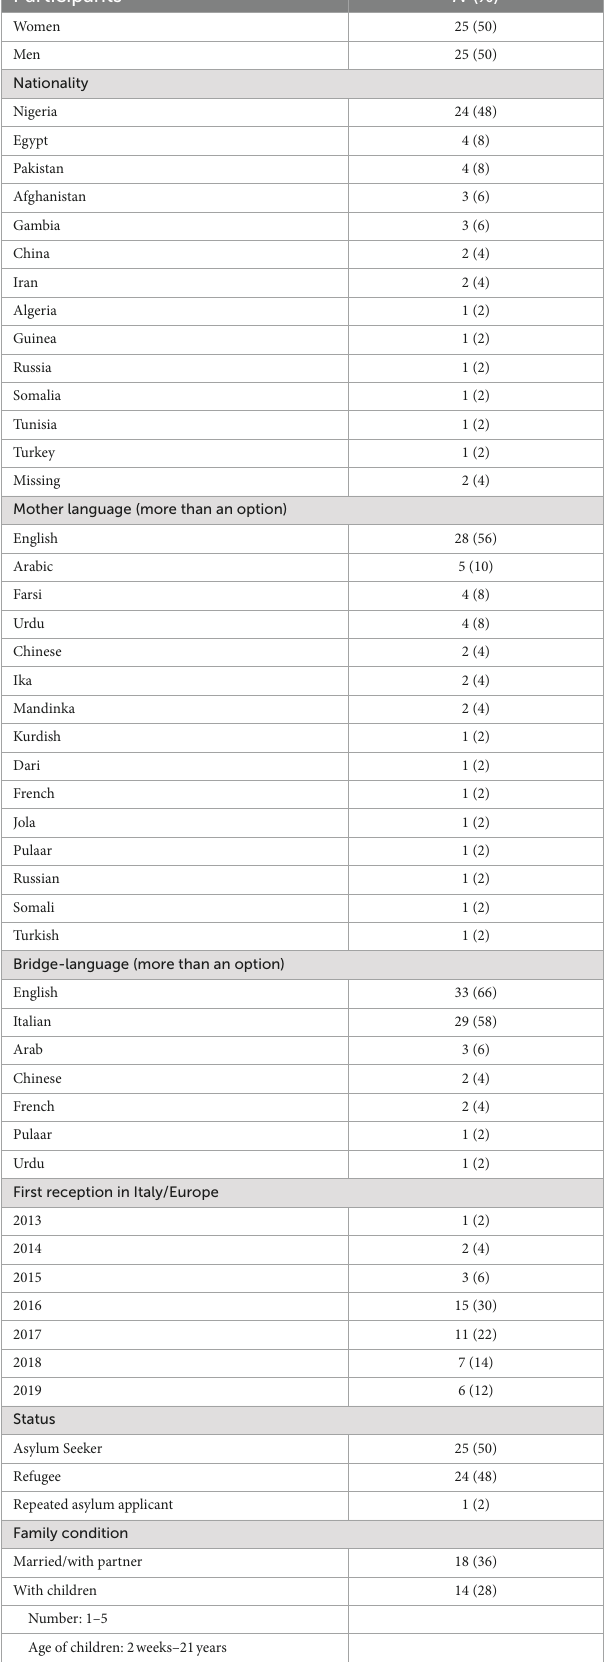
TABLE 3 Socio-demographic characteristics of Asylum Seekers and Refugees